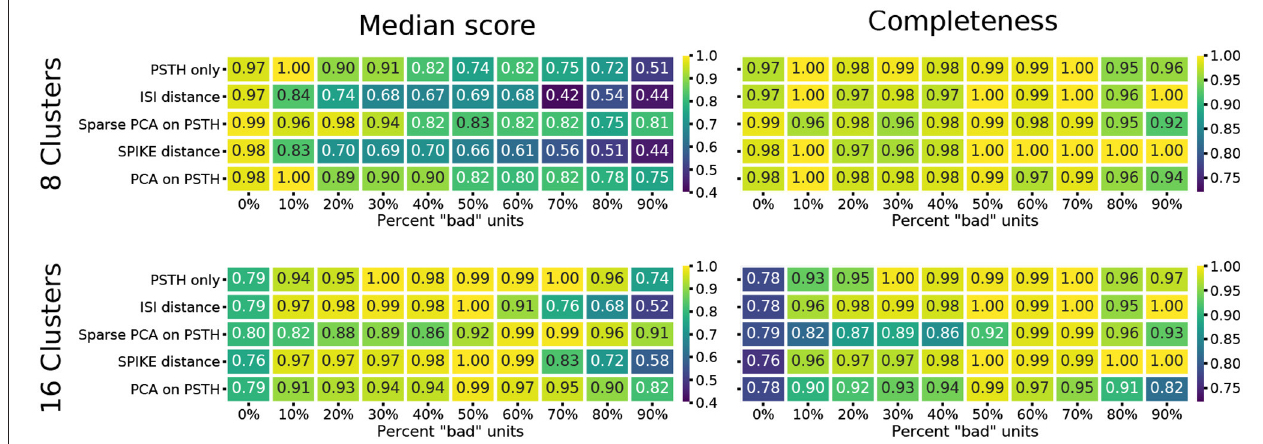
FIGURE 4 | Clustering quality scores on noisy data. For each of the five methods, the median of four external clustering quality scores (adjusted Rand index, adjusted mutual information score, V-measure, and the Fowlkes-Mallows score) are shown in the left panels. Right panels show the completeness score. The top row show the results for 8, and the bottom row for 16 flat